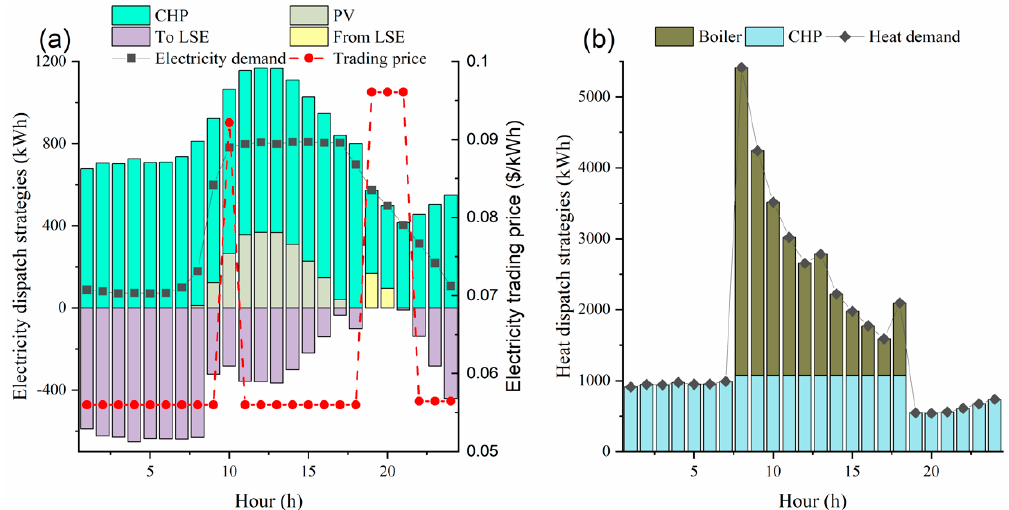
Figure 6. Energy dispatch strategies of CES2 under the decentralized coordination scheme: ( a ) electricity dispatch strategies; ( b ) heat dispatch strategies.